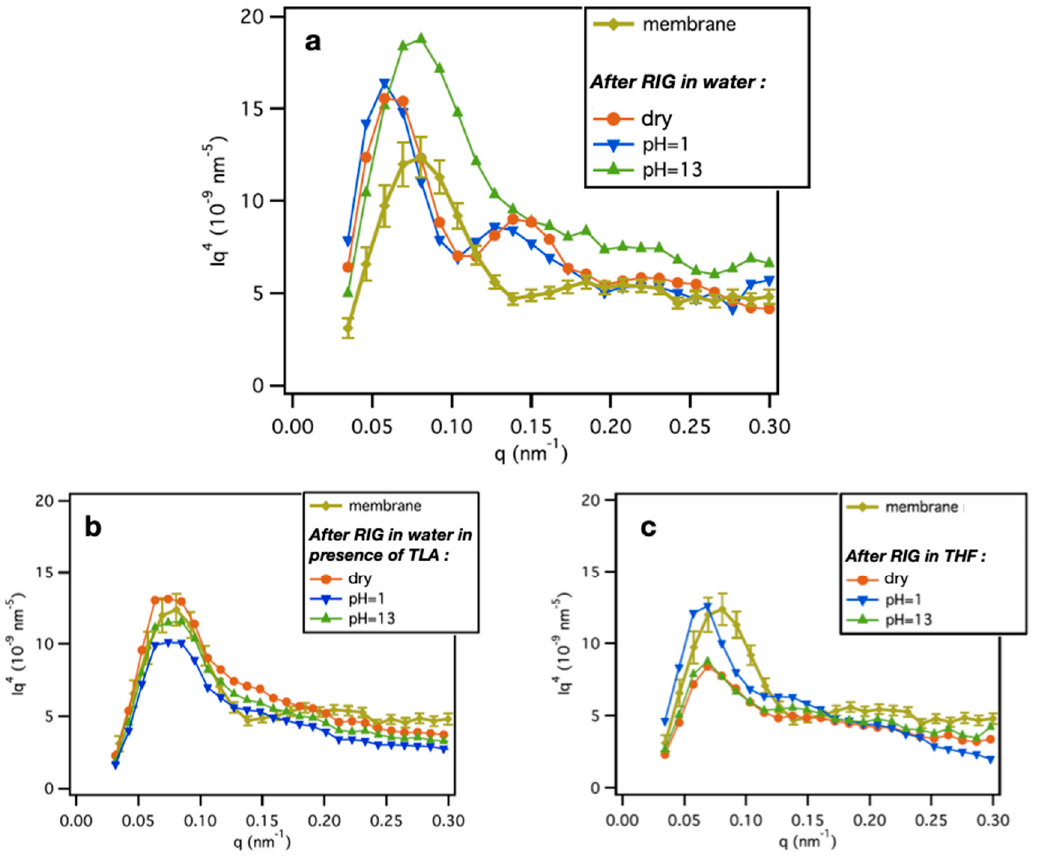
Figure 12. Small Angle Neutron Scattering (SANS) spectra obtained at LLB CEA Saclay, France (PACE spectrometer) for track-etched PVDF membranes exhibiting nanopores of 50 nm of initial radius (green circles), radiation grafted with PAA: ( a ) [AA] = 75% in water; ( b ) [AA] = 75% in water in presence of transfer agent, the thiolactic acid ([TLA] = 2.10 − 3 M) ( c ) [AA] = 25% in THF.